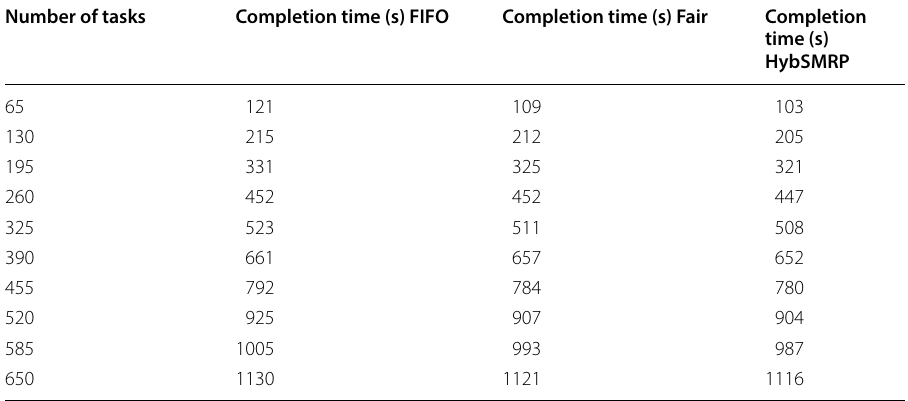
Table 6 Numerical comparison of HybSMRP with FIFO and Fair scheduler based on completion time on Wordcount Number of tasks